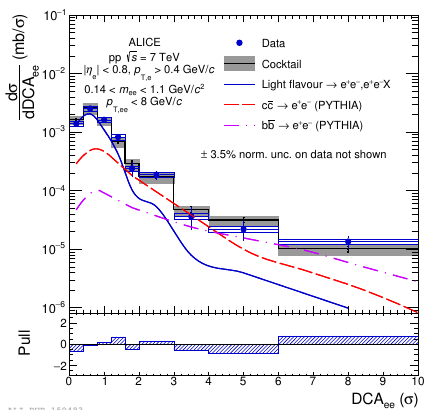
Figure 2. Dielectron spectrum as a function of DCA ee for 0.14 < m ee < 1.1GeV/ c 2 [1].